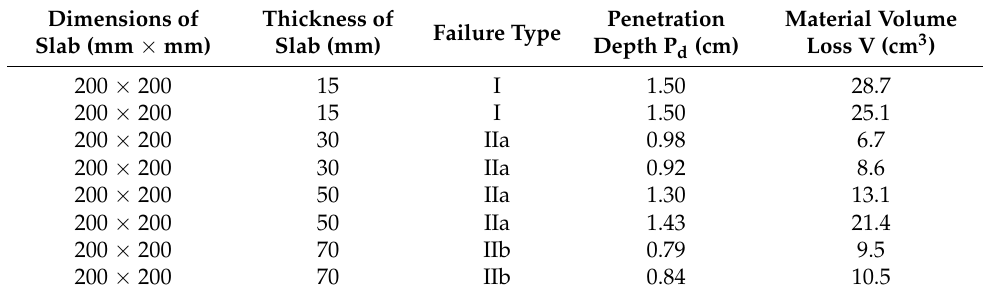
Table 7. Projectile impact results for mixture